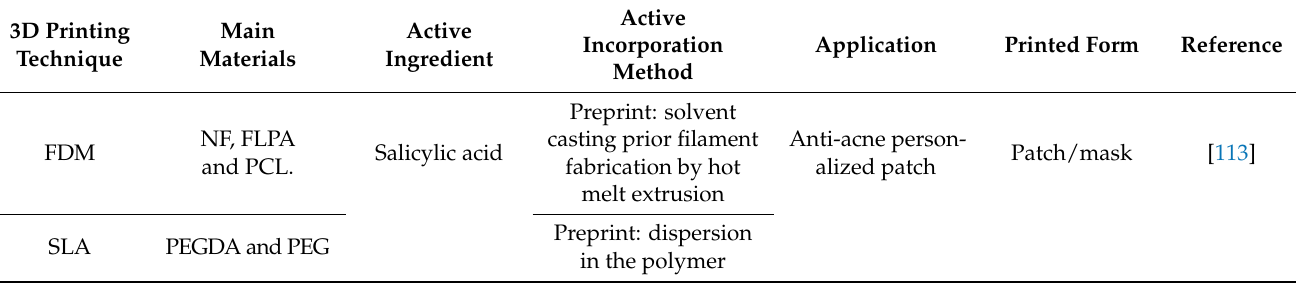
Table 2. 3D-printed products for topical delivery of active